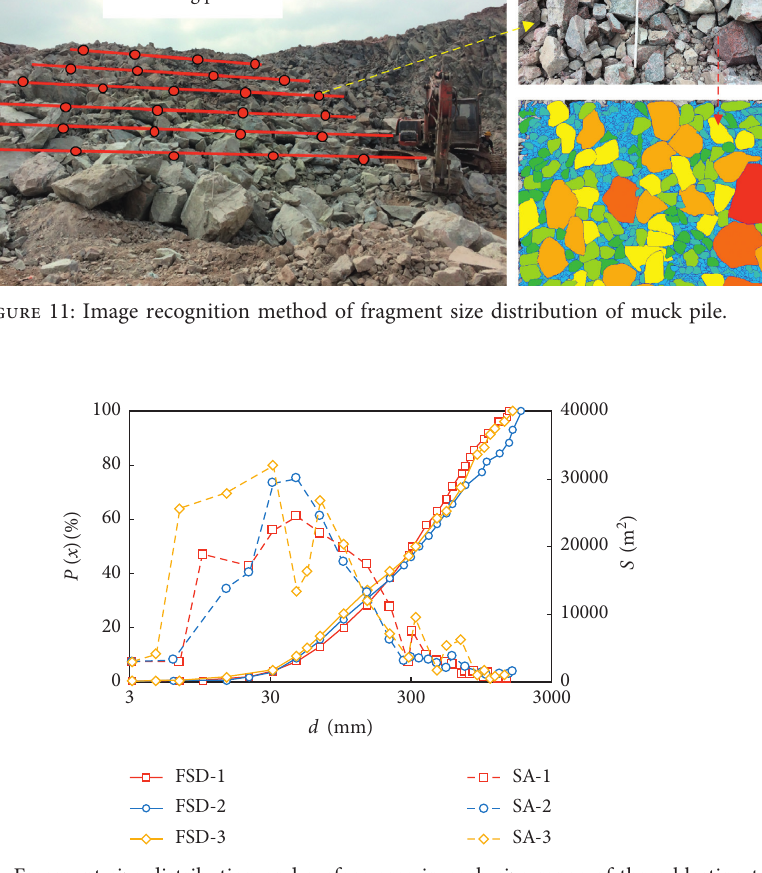
Figure 12: Fragment size distribution and surface area in each size range of three blasting